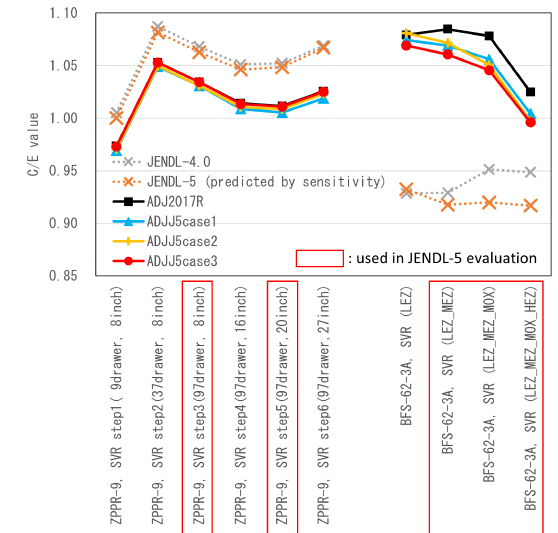
Figure 2. C / E values of reaction rate ratio of C28 / F49